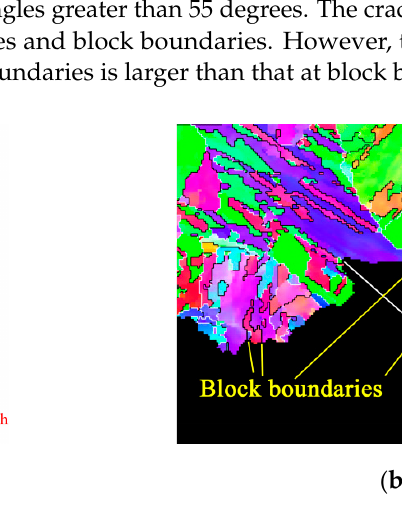
Figure 10. Correlation between microstructure and strength: ( a ) presents the correlation between M/LB substructure size and strength, ( b ) presents a linear relationship between lath width and strength, ( c ) presents a correlation between lath width and martensite fraction and ( d ) presents the correlation between martensite fraction and strength.